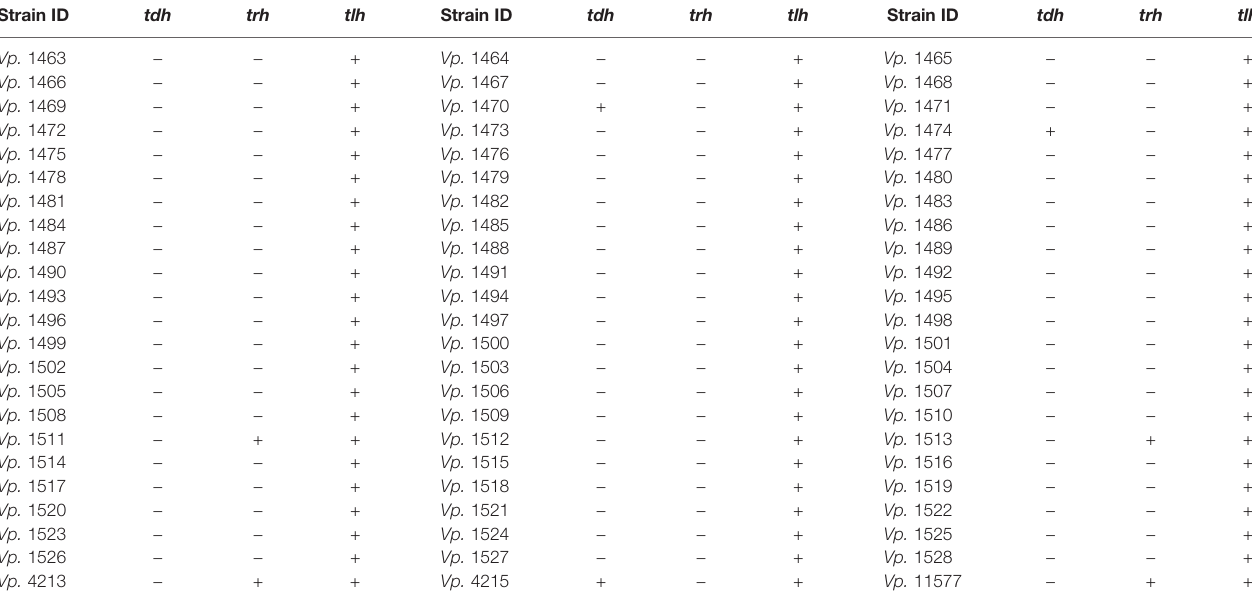
TABLE 1 | Hemolysin features of V. parahaemolyticus